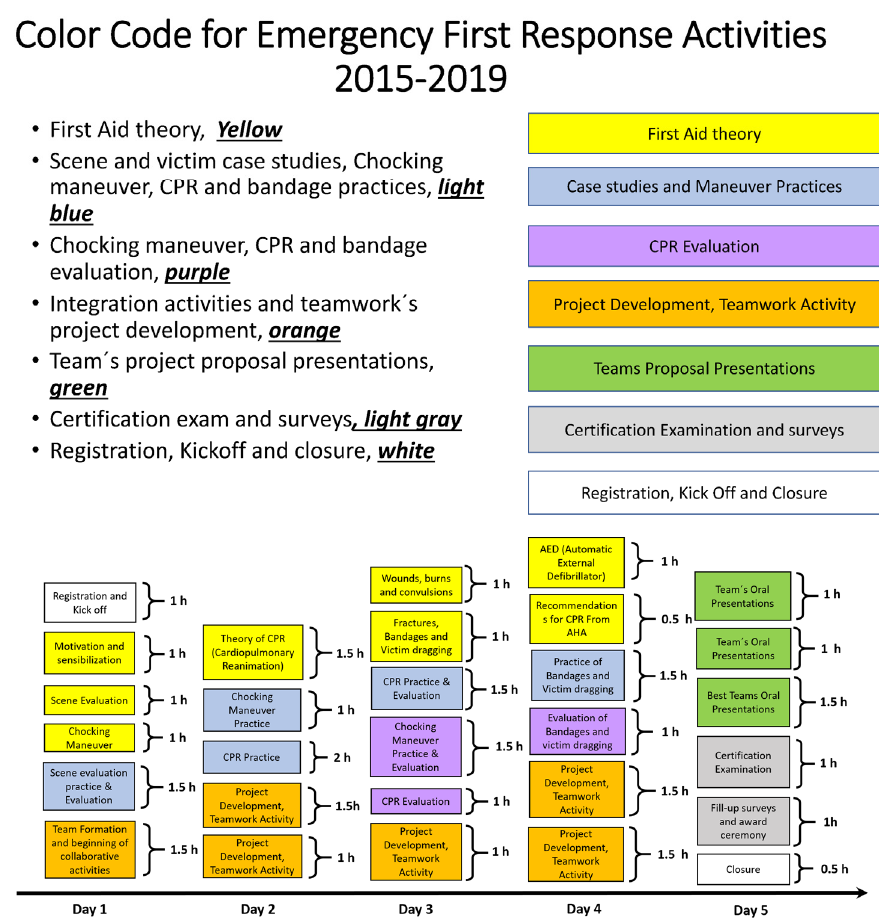
Figure A7. Color code and 5-day blocks of scheduled activities for the EFR workshop.